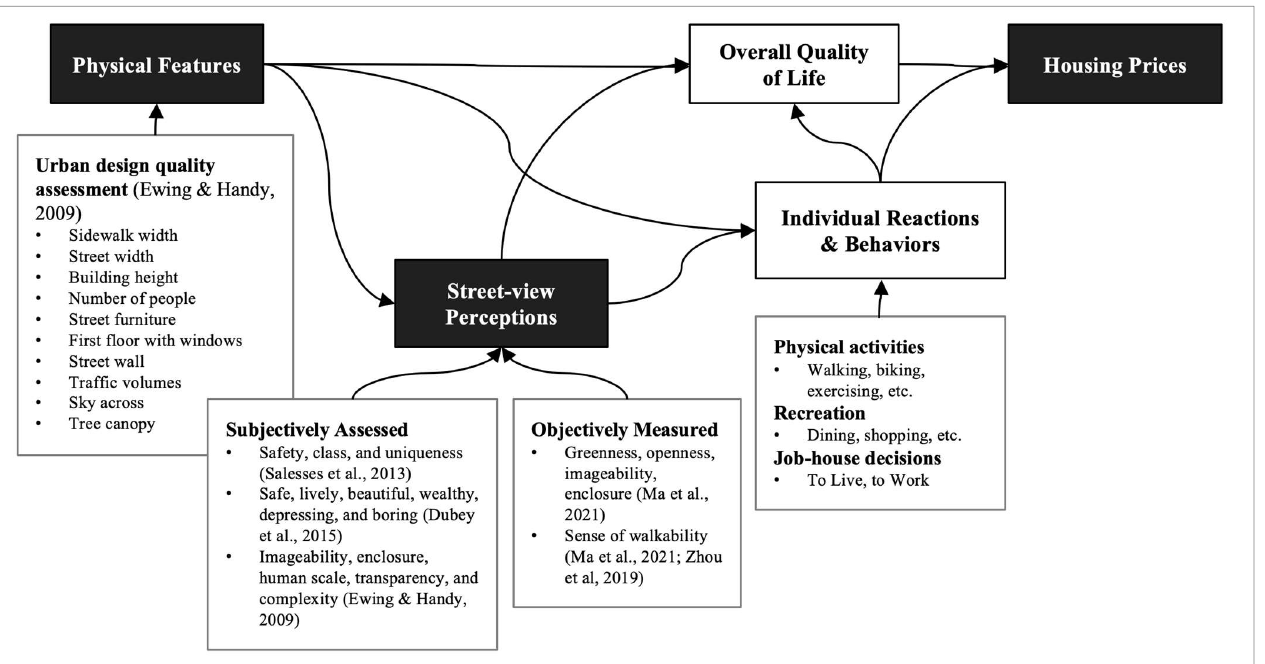
Figure 1. Conceptual framework. (Inspired by Ewing and Handy, 2009 [37]).